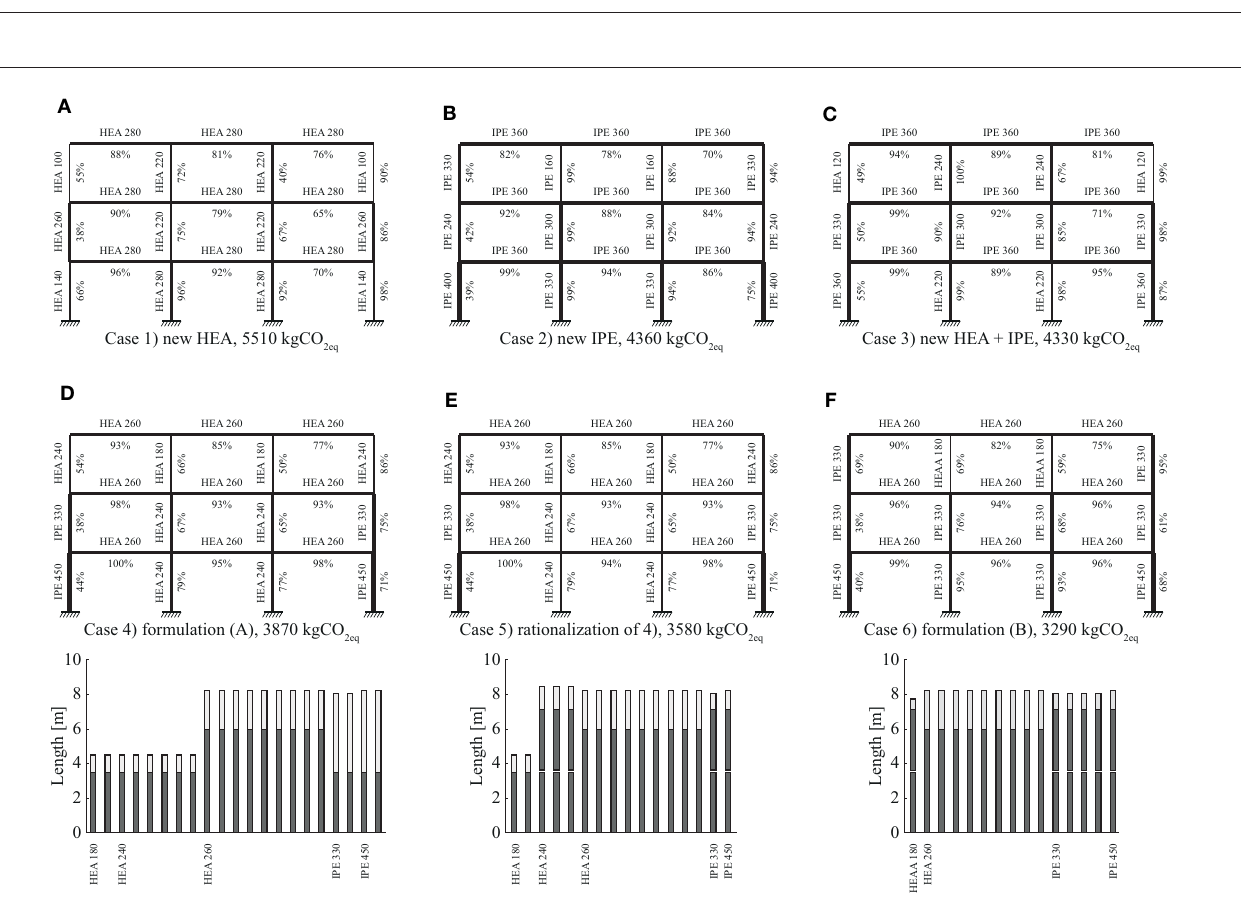
elements in case (5). Further improvements are achieved in case (6) where IPE 330 elements replace HEA 240 elements because the former have a higher moment-resistance-to-mass ratio than the